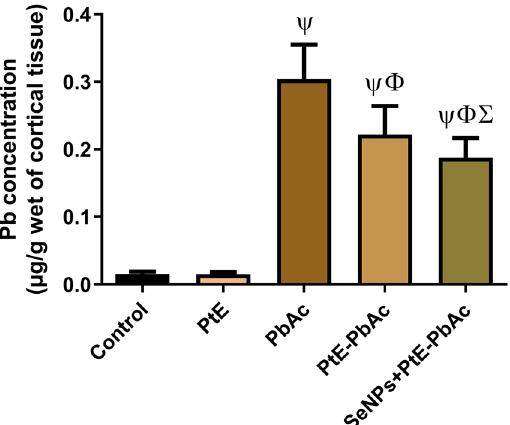
Figure 2: E ff ects of orally administered PtE or PtE - SeNPs on lead bioaccumulation in the brain of PbAc - injected rats. ψ , Φ , Σ superscript letters indicate statistical signi fi cance at P < 0.05 against control, PbAc, and PtE - PbAc group, respectively. All results are presented as the mean + SD.